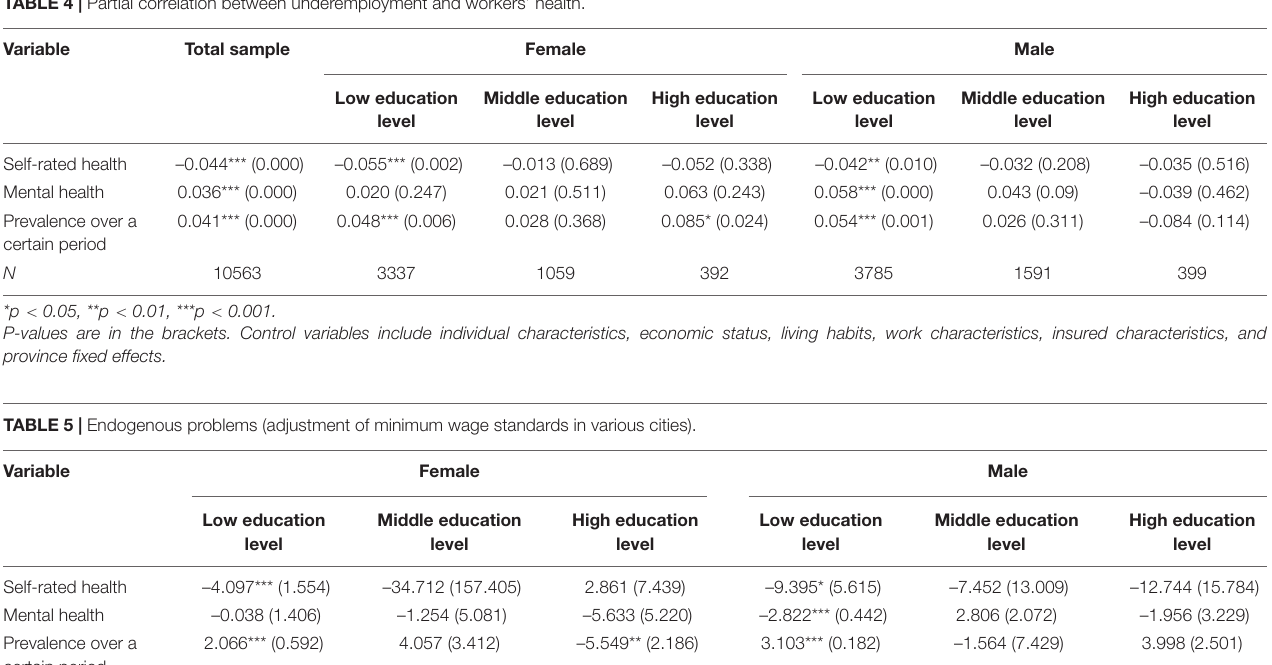
TABLE 4 | Partial correlation between underemployment and workers’ health.